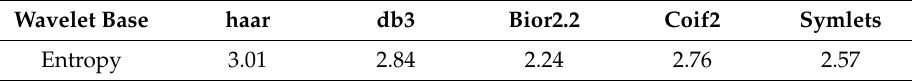
Table 1. There are five common entropy values of wavelet-based instances